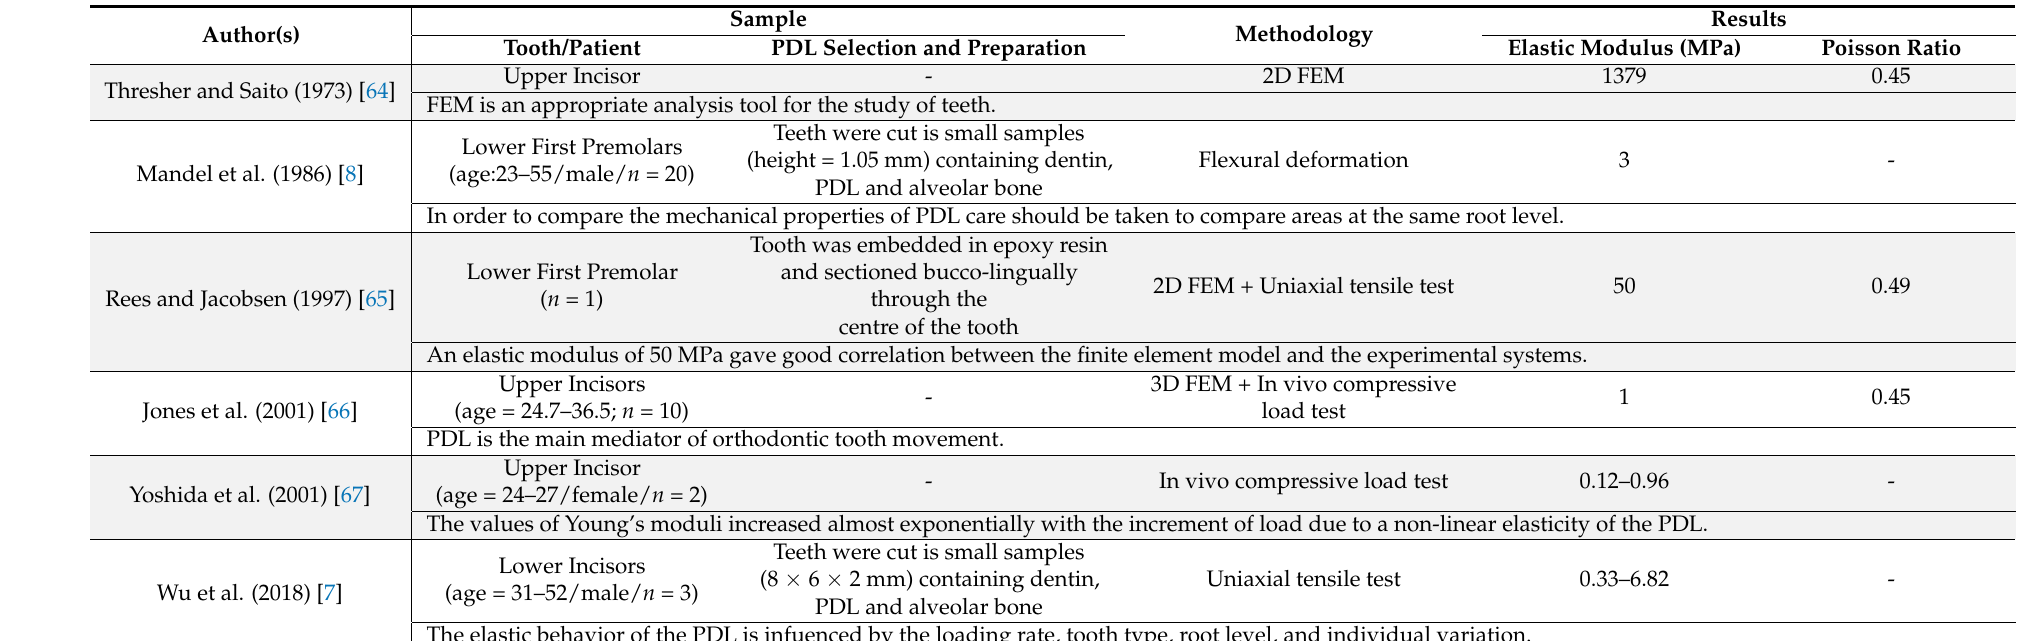
Table 4. Data for PDL Mechanical